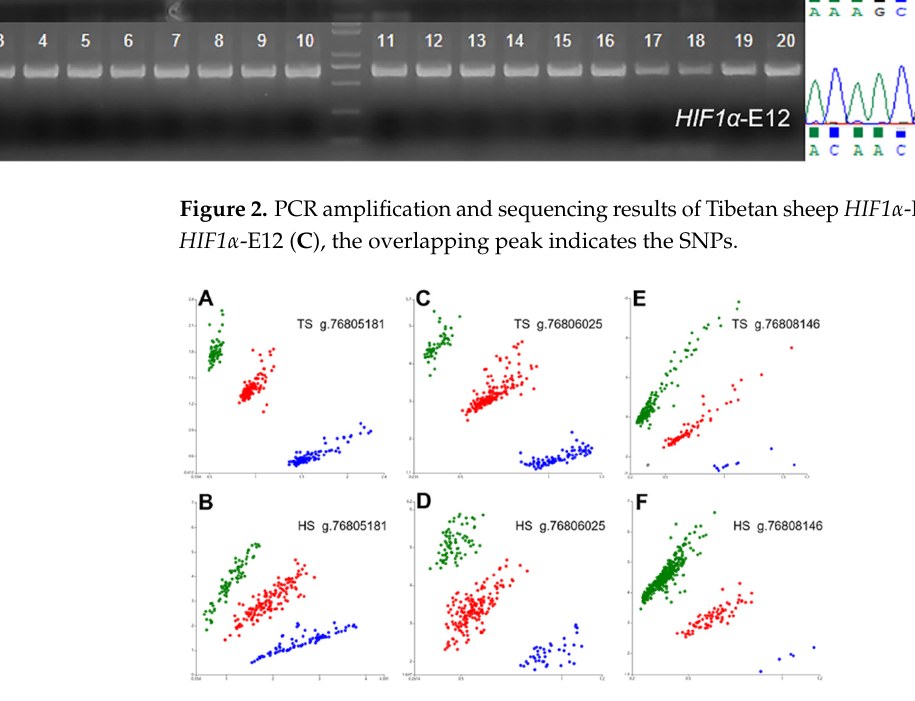
Figure 3. KASP genotyping assay results of three positions of HIF-1 α gene in Tibetan sheep (TS) and Hu sheep (HS). The red, blue and green dots in ( A – D ) indicates GA , GG , and AA genotype, respectively, and in ( E , F ) indicates TA , AA and TT genotype, respectively. Figure 2. PCR amplification and sequencing results of Tibetan sheep HIF1 α -E9 ( A ), HIF1 α -E10 ( B ) and HIF1 α -E12 ( C ), the overlapping peak indicates the SNPs. Table 2. Frequencies of genotype and allele in three positions of HIF-1 α gene in Tibetan sheep (TS) and Hu sheep (HS).